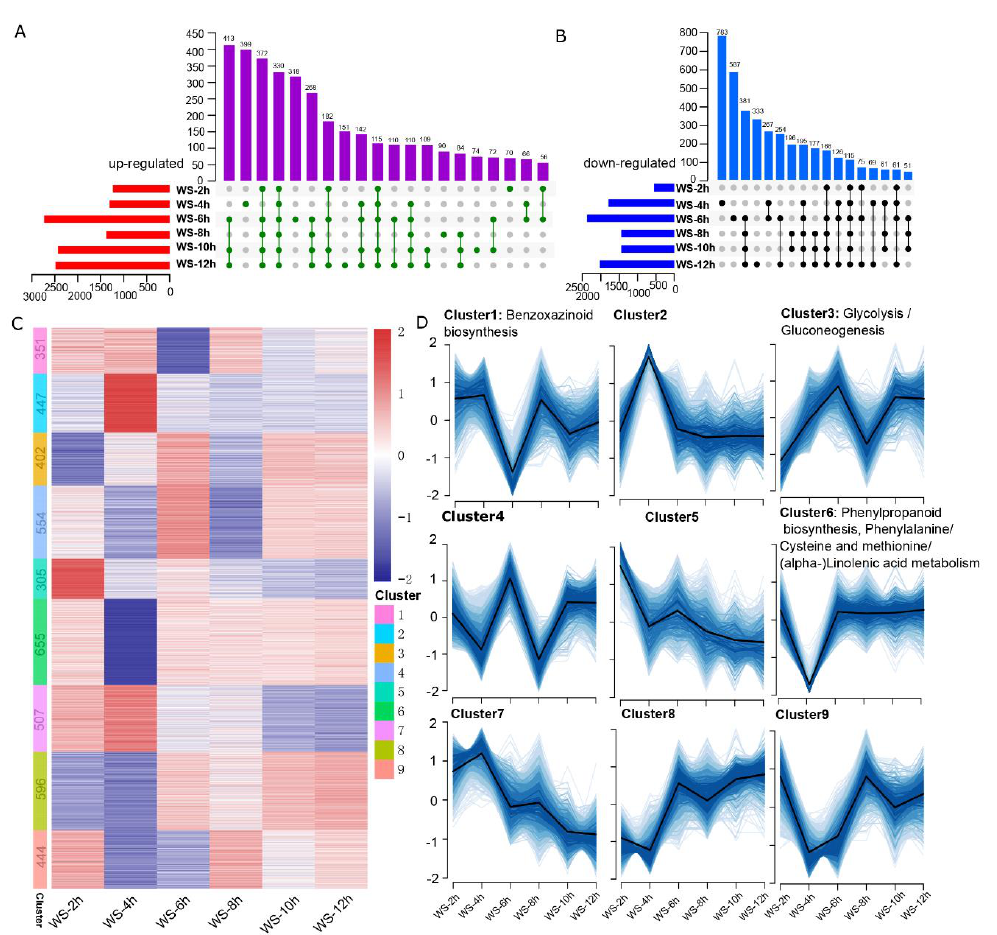
Figure 1. The characteristics of differentially expressed protein coding genes (DEpcGs) after waterlogging stress (WS). The Venn diagram shows the number of up-regulated DEpcGs ( A ) and down-regulated DEpcGs ( B ) after 2 h (WS_2h), 4 h (WS_4h), 6 h (WS_6h), 8 h (WS_8h), 10 h (WS_10h), and 12 h (WS_12h) of stress. These DEpcGs are divided into 9 clusters based on the ‘mfuzz’ package in the R software and were displayed using a heatmap ( C ) and their expression tendency ( D ). The numbers in the heatmap represent the DEpcG amounts in each cluster, and the significantly enriched KEGG pathways in Cluster1, Cluster3, and Cluster6 are